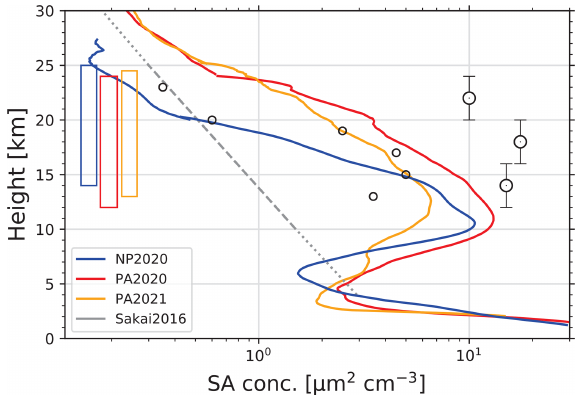
Figure 14. Correlation between smoke particle surface area (SA) concentration and the additional ozone loss observed over the Arc- tic (blue) and over Antarctica (red, orange). The smoke–ozone data pairs are taken from Figs. 7 and 12. Considered are data from 10– 12km (PSC-free height range) and from 13–25km height (PSC height range) with a height resolution of 1km. For comparison, two values (for PSC-free conditions) for volcanic aerosol scenarios are included (Calbuco, low SA conc., Zhu et al., 2018; Pinatubo, high SA conc., Ansmann et al.,